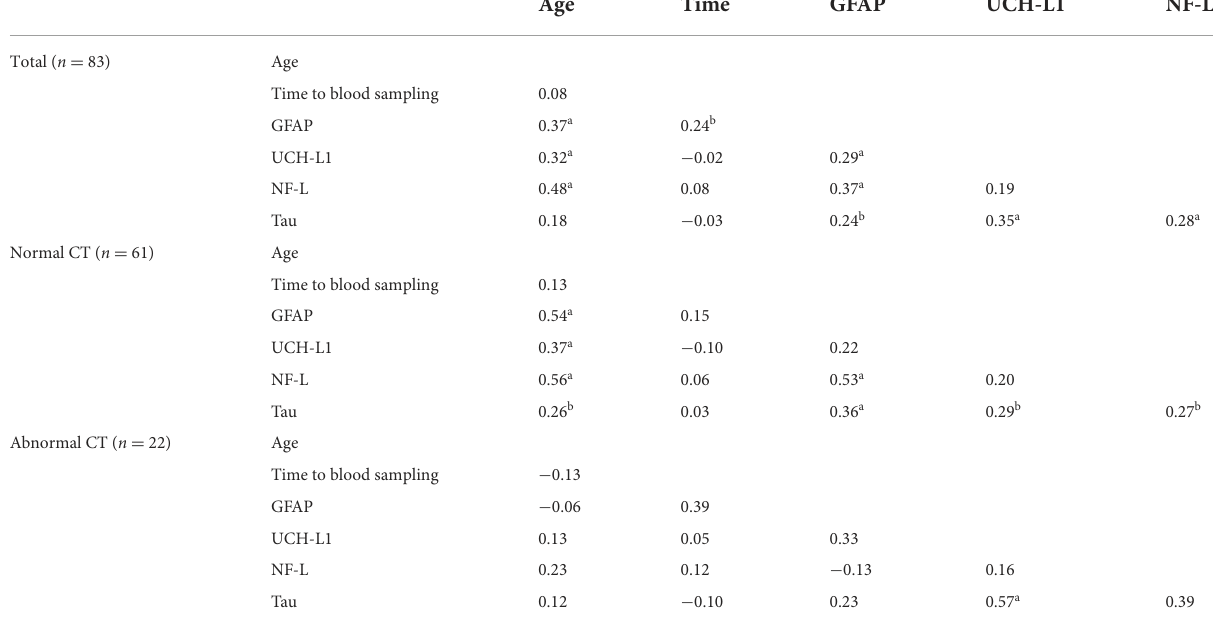
TABLE 4 Spearman intercorrelation